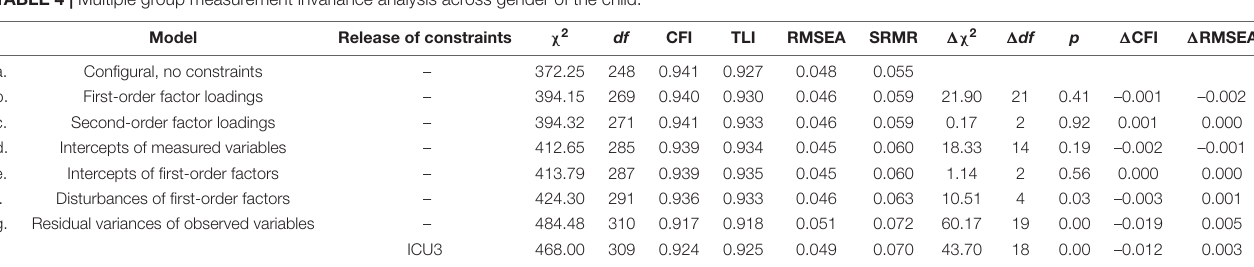
TABLE 4 | Multiple group measurement invariance analysis across gender of the